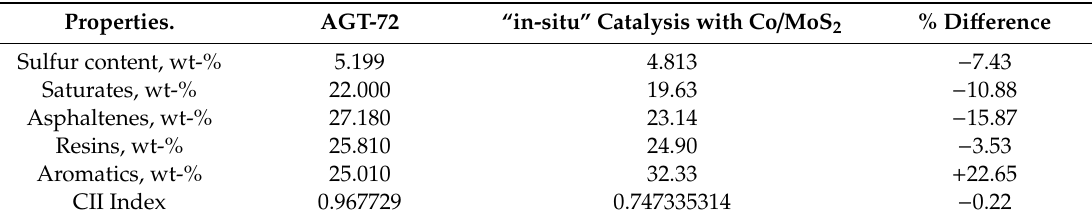
Table 1. SARA analysis of AGT-72 before and after treatment with unsupported Co/MoS 2 catalyst at 350 °C for 8 h, showing a compositional modification due to the catalytic interaction with spherically shaped nanoparticles.